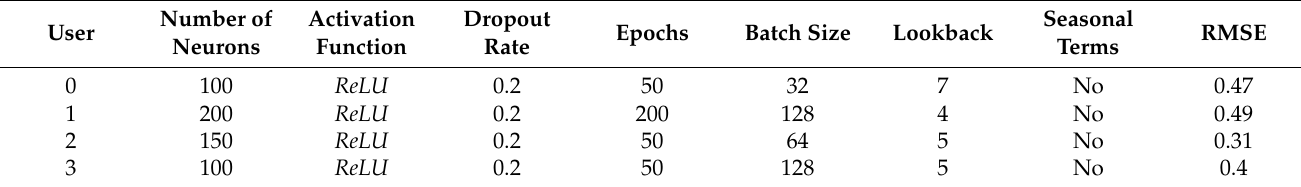
Table 2. Results of the hyperparameter tuning for each